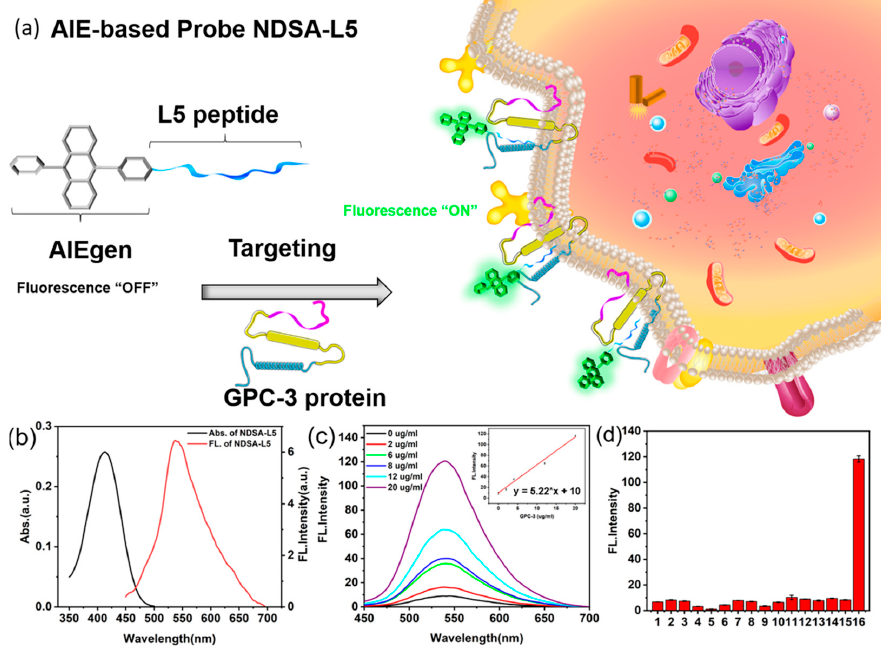
Figure 1. ( a ) Recognition process of NDSA-L5 probe for GPC-3. ( b ) Absorption and emission spectra of NDSA-L5 in DMSO, ( c ) fluorescence response of NDSA-L5 related to GPC-3 (0 − 20 µ g/mL),